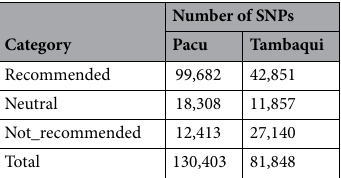
Table 1. SNPs classification according the Axiom quality control criteria ( p-convert ).